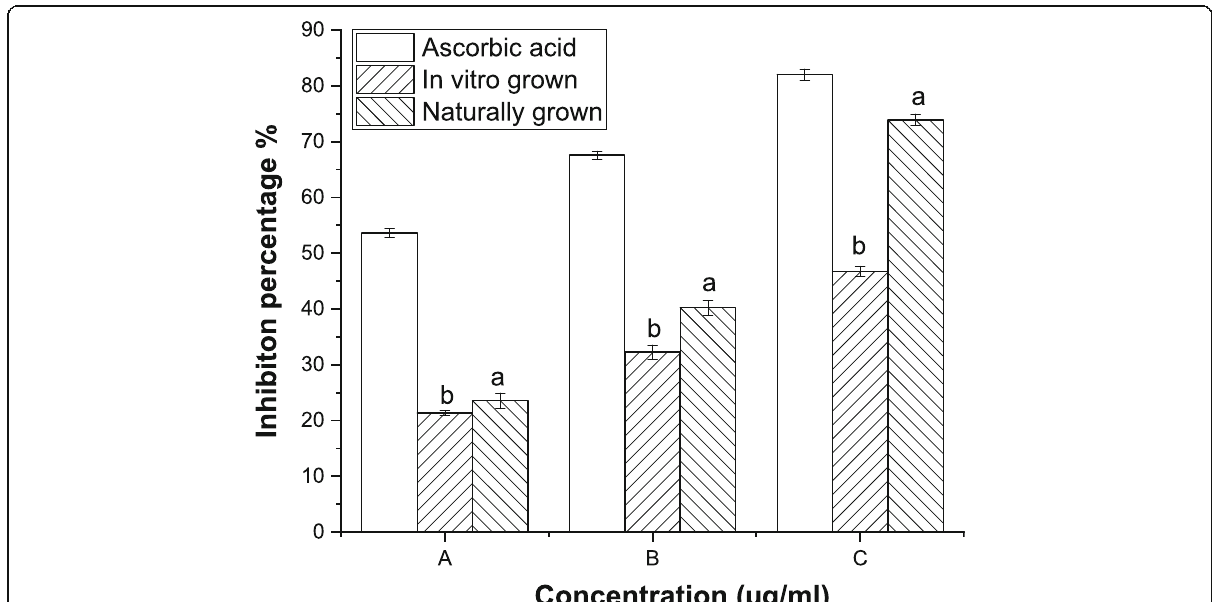
Fig. 2 DPPH • scavenging activity of in vitro and naturally grown L. cruciata and their comparison with standard Ascorbic acid . Values with different letters (a, b) are significantly ( p <0.05) different from each other by Turkey ’ s multiple range test